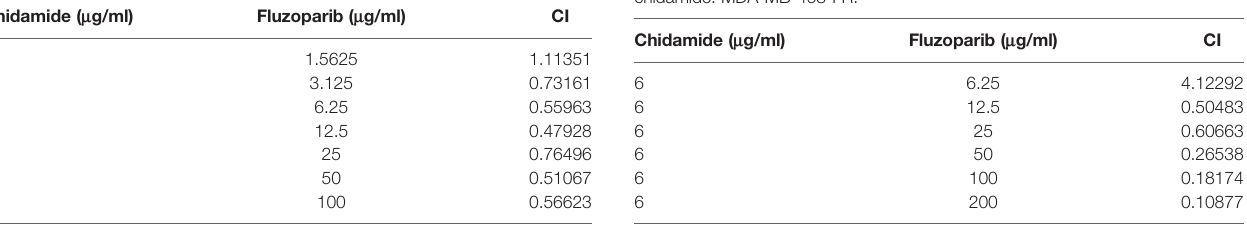
TABLE 3 | The combination index of different doses of fl uzoparib and 6 m g/ml chidamide: MDA-MB-468-FR. Chidamide ( m